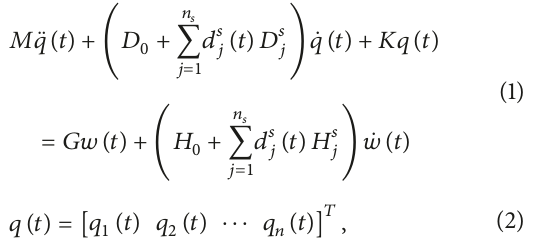
Figure 1. The equation of motion and the state-space form